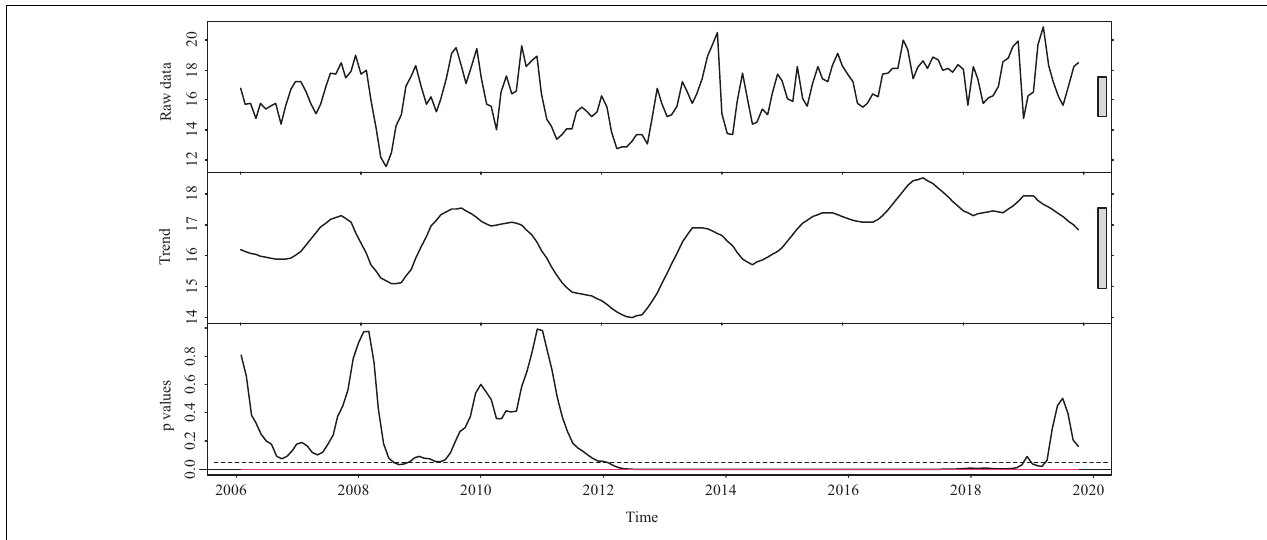
FIGURE 4 | The temperature (two components: raw data and trend) and corresponding p -value before the spawning season (from January to March) during 2006–2019 in the Pearl River (China). The gray boxes represent the relative magnitude of variation in each component. The trend component is derived by locally weighted scatterplot smoothing. The red line represents the corresponding p -value of the boundary of the F statistics at the confidence level of 99%. The dotted line shows where the p -value equals 0.05.